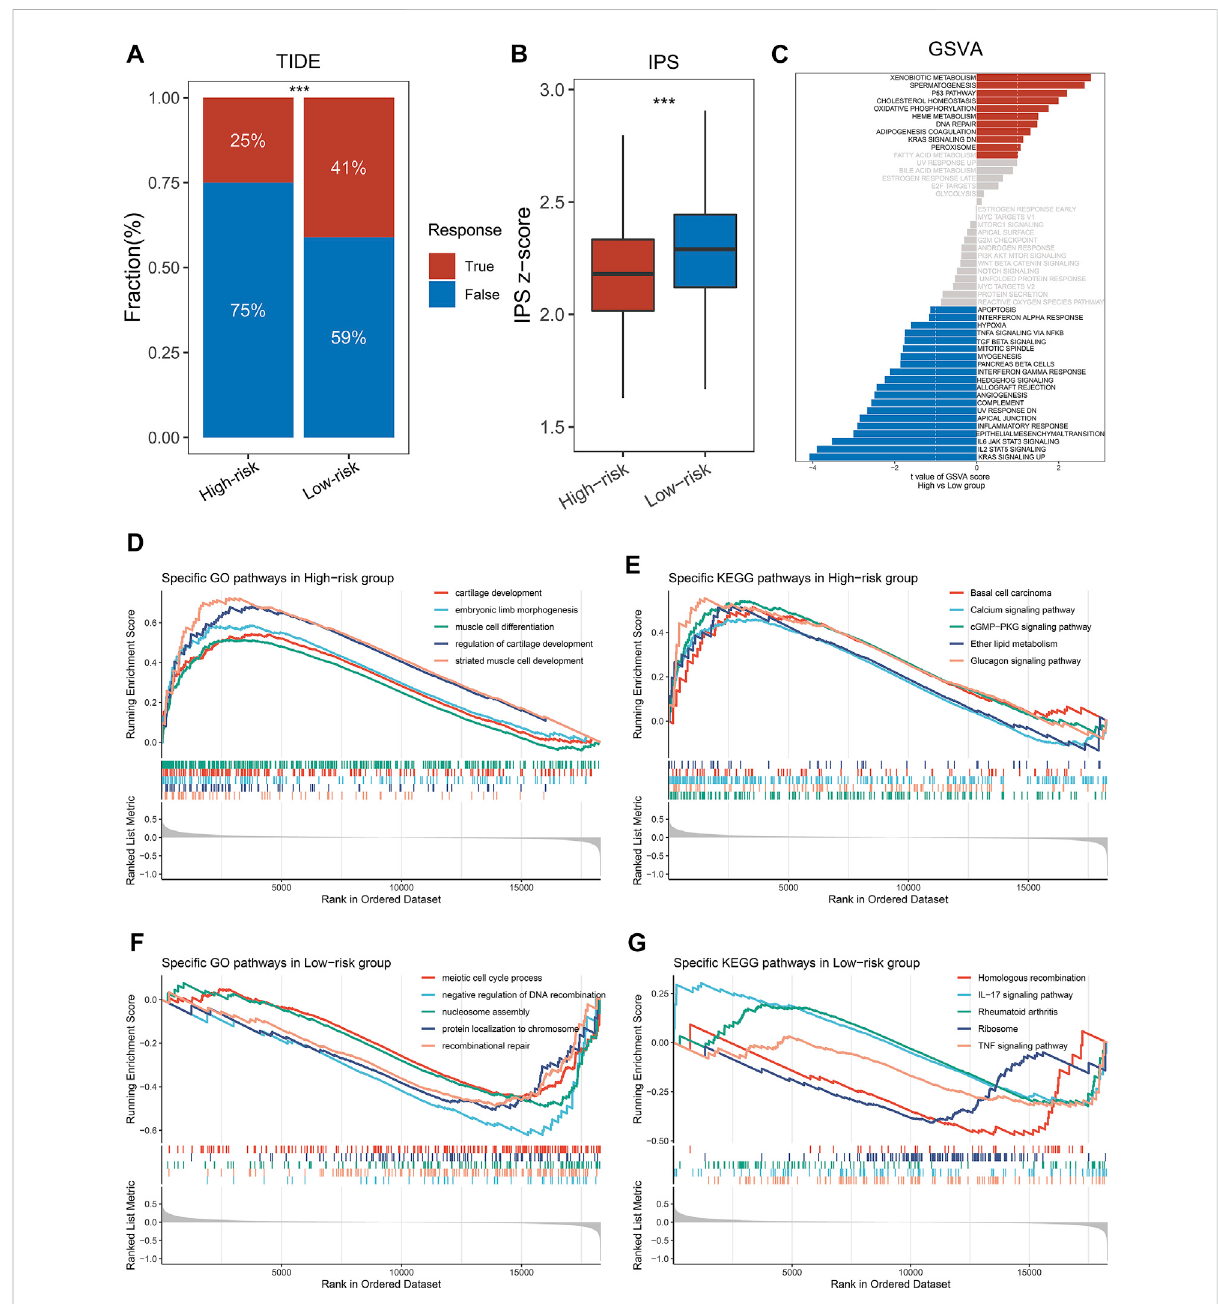
FIGURE 5 Exploring the potential mechanisms of NLPS. (A) TIDE was utilized to predict the response of immune checkpoint inhibitors in high- and low- risk groups. (B) The difference of IPS score between the high- and low-risk. (C) GSVA enrichment analysis. (D – G) The top fi ve GO terms and KEGG pathways in the two groups. * p < 0.05, ** p < 0.01, *** p < 0.001, **** p <